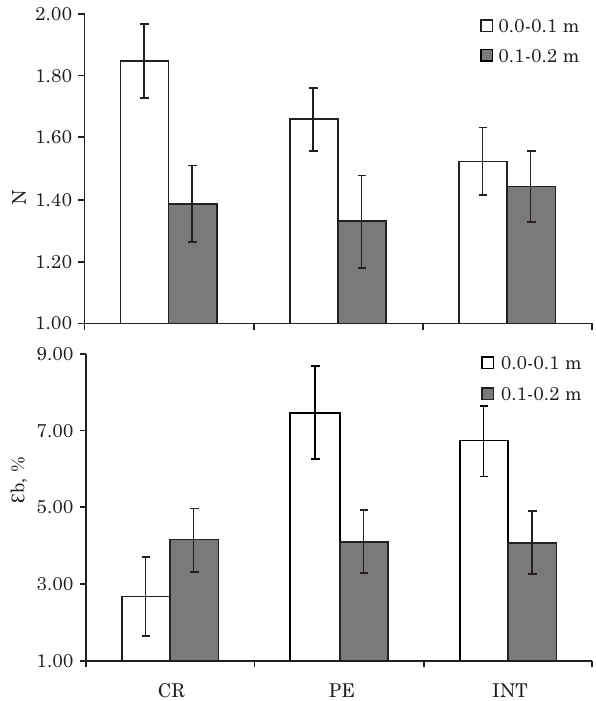
Figure 3. Mean values of the regression parameter (N) between log K a and log Ɛ a and blocked pores ( Ɛ b ) at the sampling locations crop row (CR), interrow (INT) and the point equidistant between CR and INT (PE) in the layers 0.0-0.1 and 0.1-0.2 m. Overlapping confidence intervals of the mean indicate no statistical difference (p>0.05).